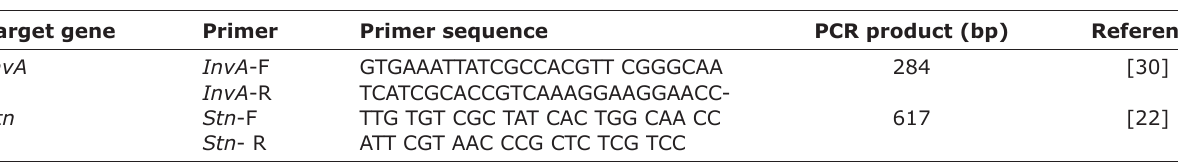
Table-1: Primers of virulence genes ( invA and stn ).